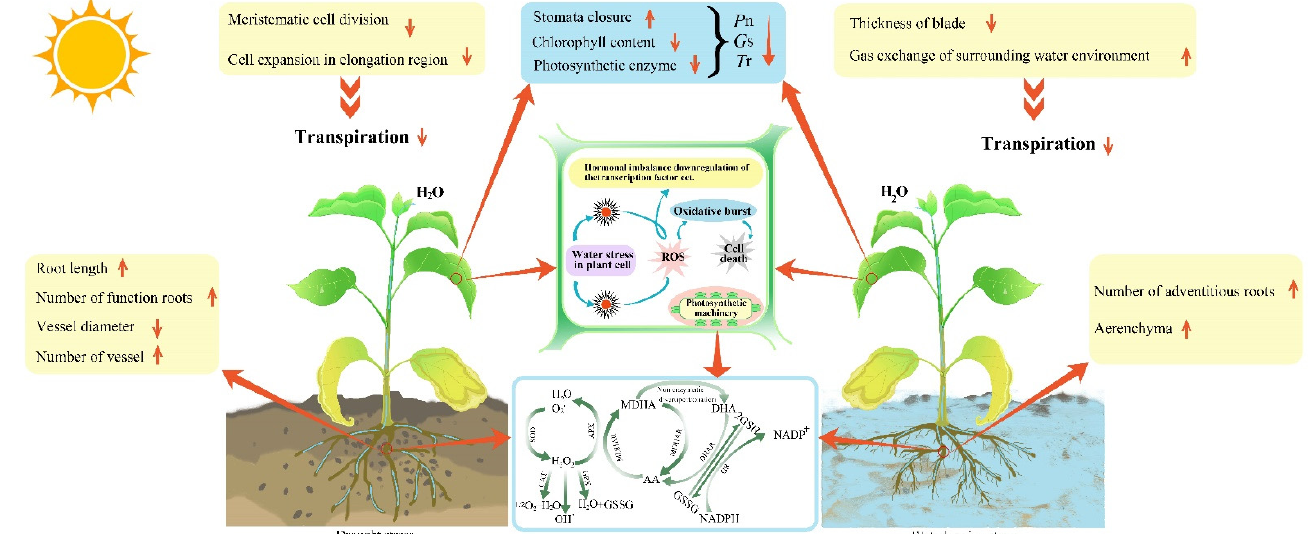
Figure 1. Changes to the morphological and anatomical structure of plant leaves and roots due to water stress. P n : net photosynthetic rate; G s : stomatal conductance; T r : transpiration rate; ROS: reactive oxygen species; SOD: superoxide dismutase; CAT: catalase; APX: ascorbic peroxidase; GPX: peroxidase; GSSG: L-glutathione oxidized; MDHA: dehydroascorbic acid reductase; MDHAR: monodehydroascorbic acid reductase; DHAR: dehydroascorbate reductase glutathione; GR: glutathione reductase; GSH: glutathione peroxidase; AA: ascorbic acid.